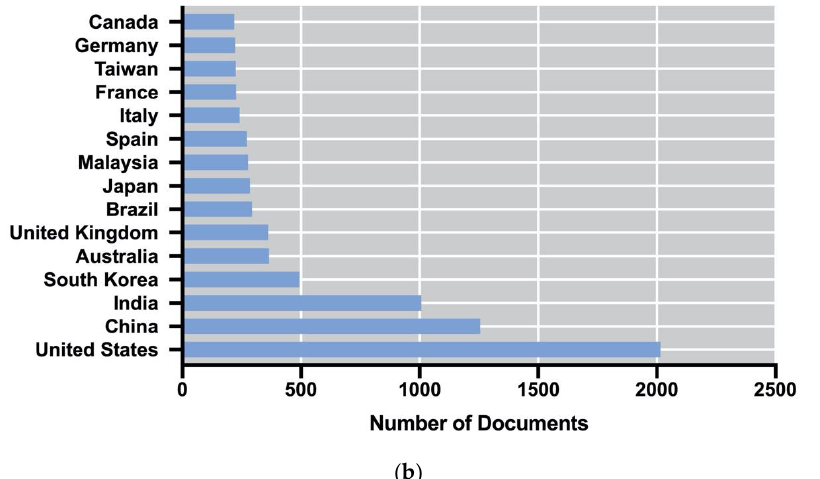
Figure 1. Evolution of the number of publications from 2003 to 2020 on algal biofuels ( a ) and their country of origin ( b ).